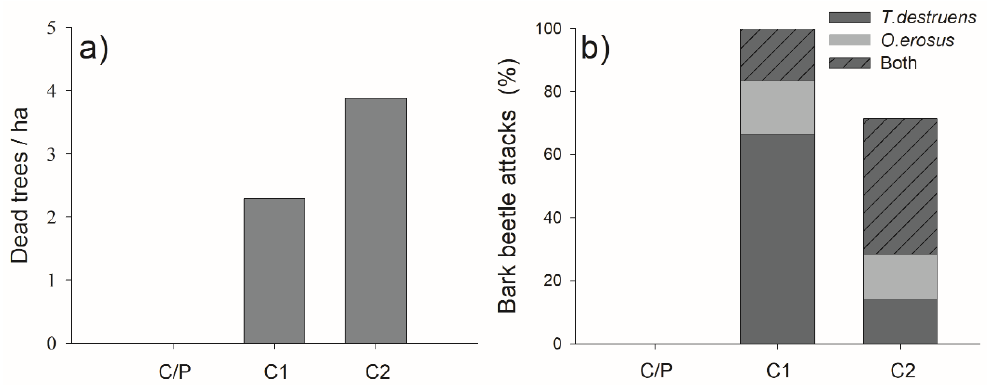
Figure 9. Panel a ) Tree mortality (dead trees / ha) in each stand considering only the trees that had recently died (i.e., trees that died less than two years ago). Panel b ) Percentage of dead trees evidencing bark beetle attacks in each pine stand. The smooth dark gray stack represents attacks by Tomicus destruens ; the smooth light gray stack represents attacks by Orthotomicus erosus ; the striped dark gray stack represents mixed attacks by both species. Recent logging did not enable us to determine the mortality and bark beetle attacks in P1.